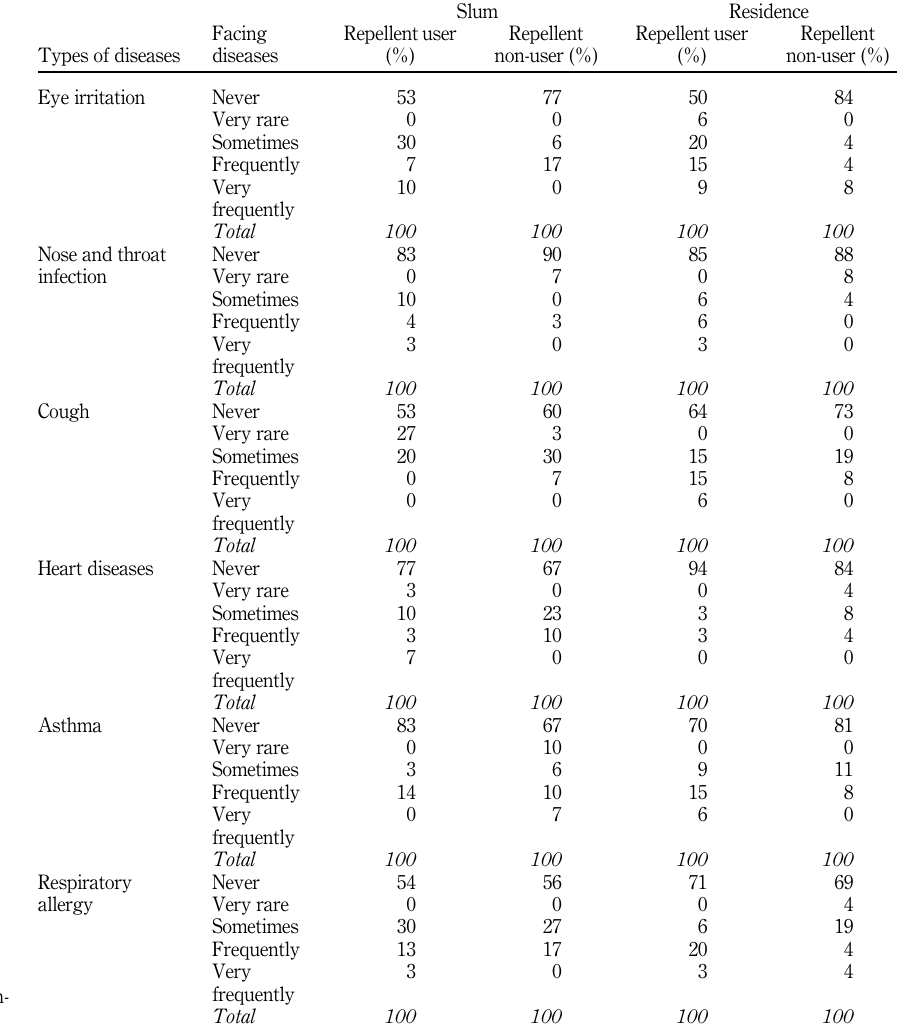
Table 3. Severity of diseases among user and non- user of